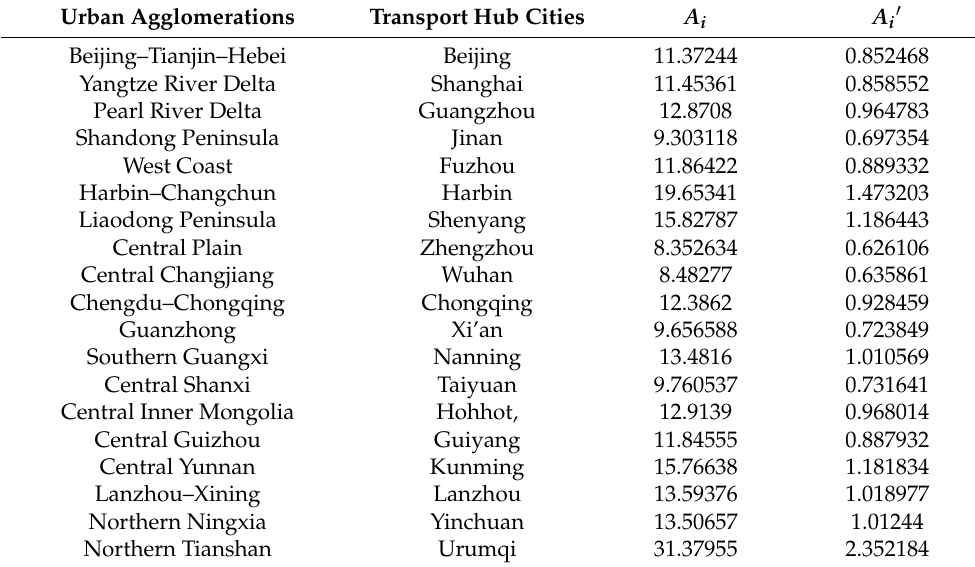
Table 3. Accessibility coefficients of 19